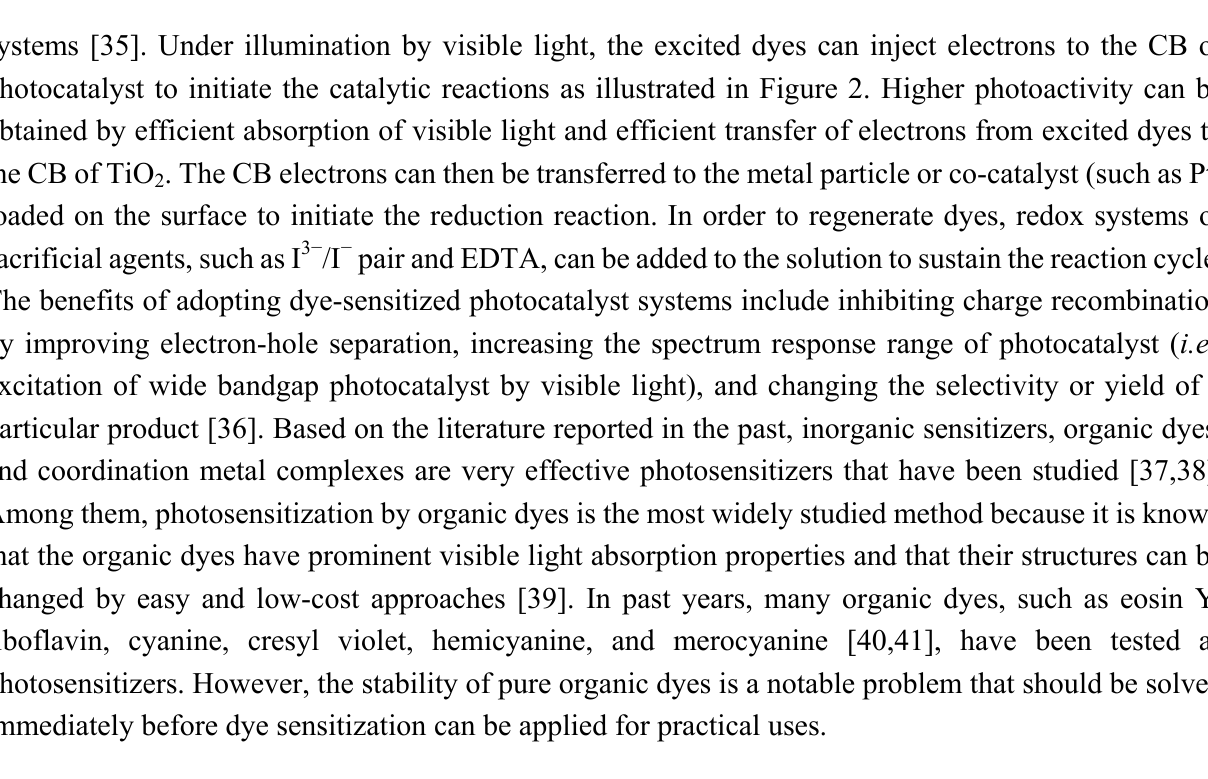
Figure 2. Mechanism of dye-sensitized photocatalytic hydrogen production under visible light